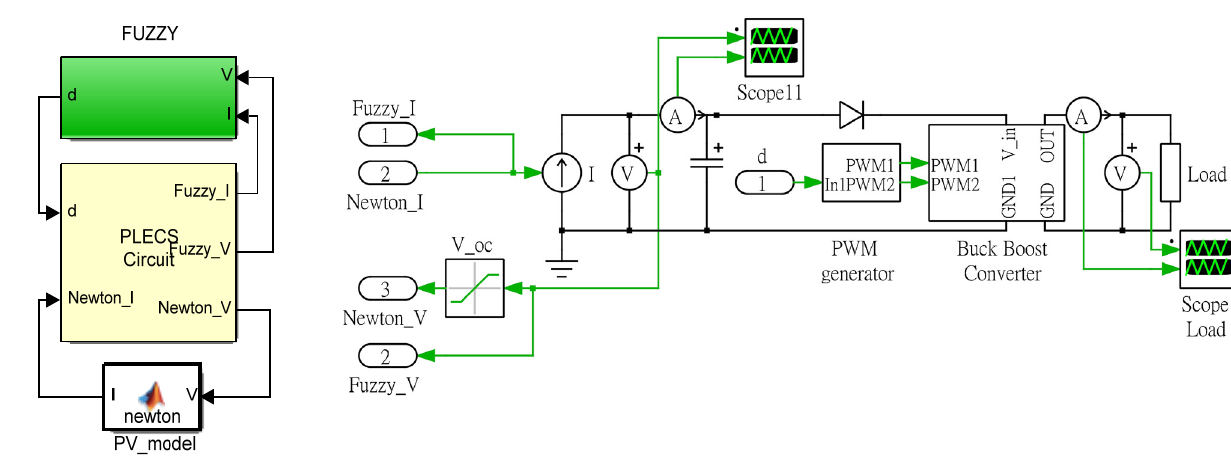
Figure 13. Circuit simulation model for buck-boost converter based MPPT system with its PLECS circuit.